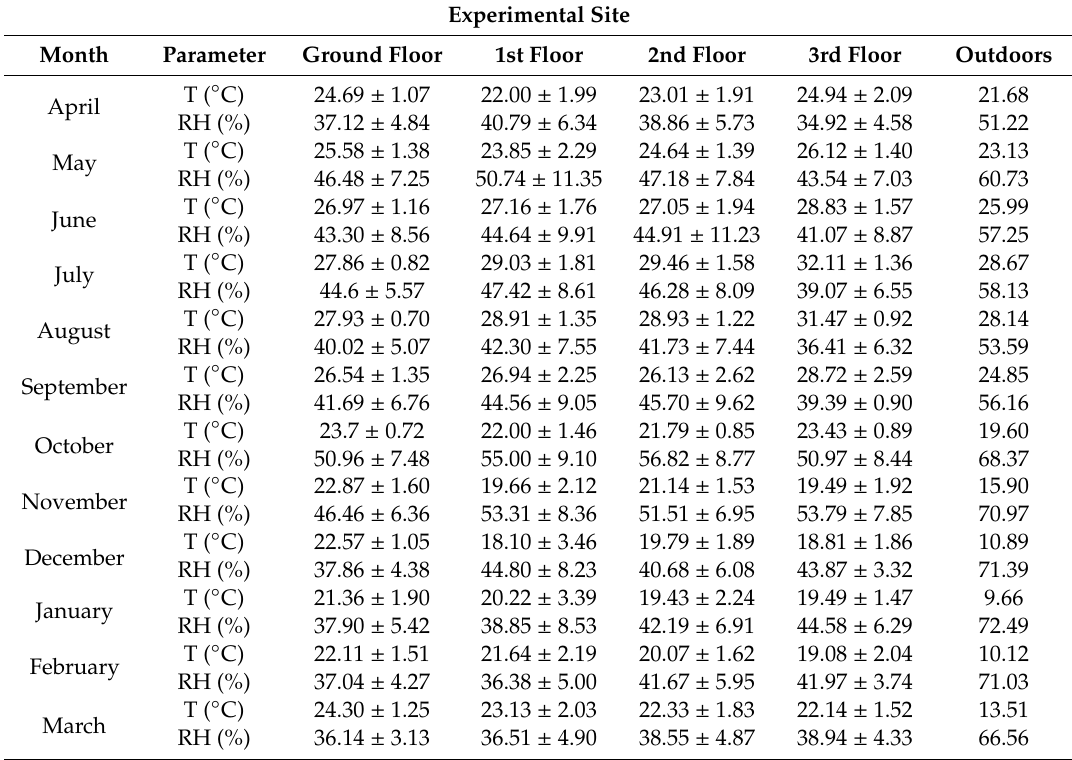
Table 2. Mean values and standard deviations of temperature ( ◦ C) and relative humidity (%) for each floor, for all experimental periods (April 2018–March